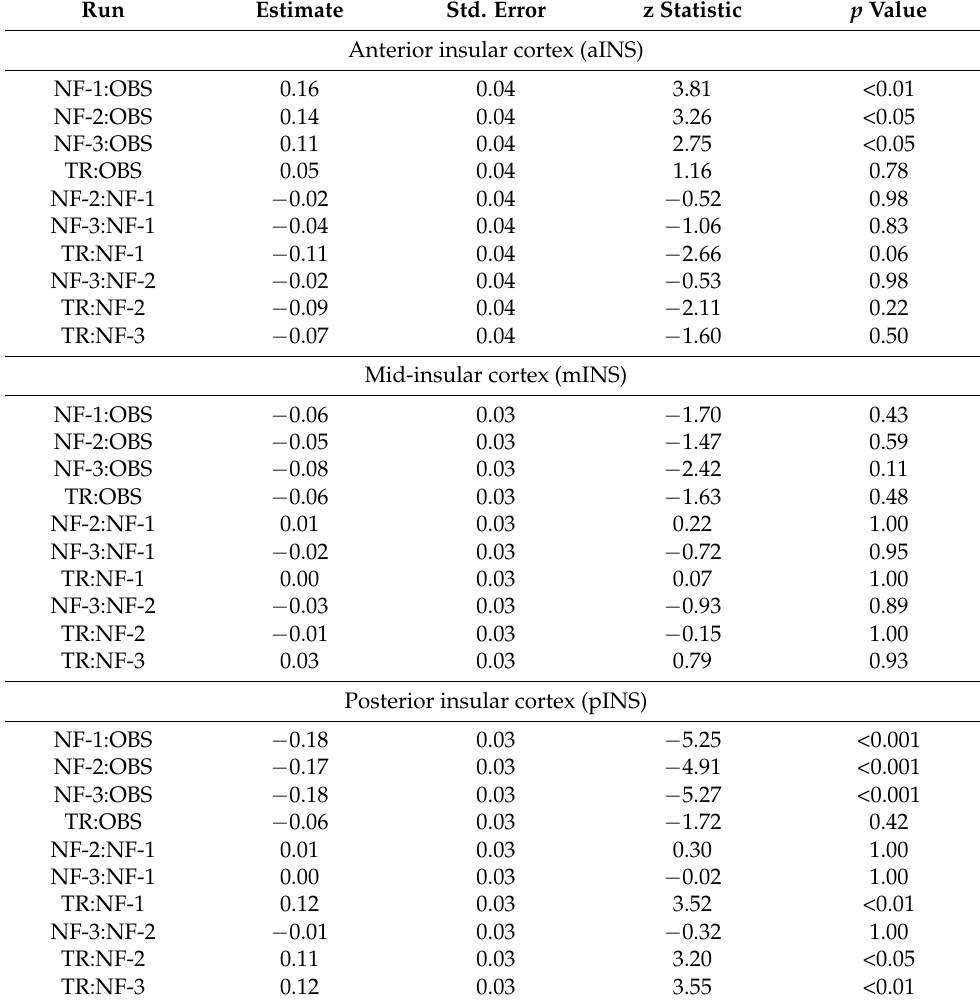
Table 5. Post hoc comparisons for parameter estimates (Focus-on-Breath vs. Describe) in INS subregions across